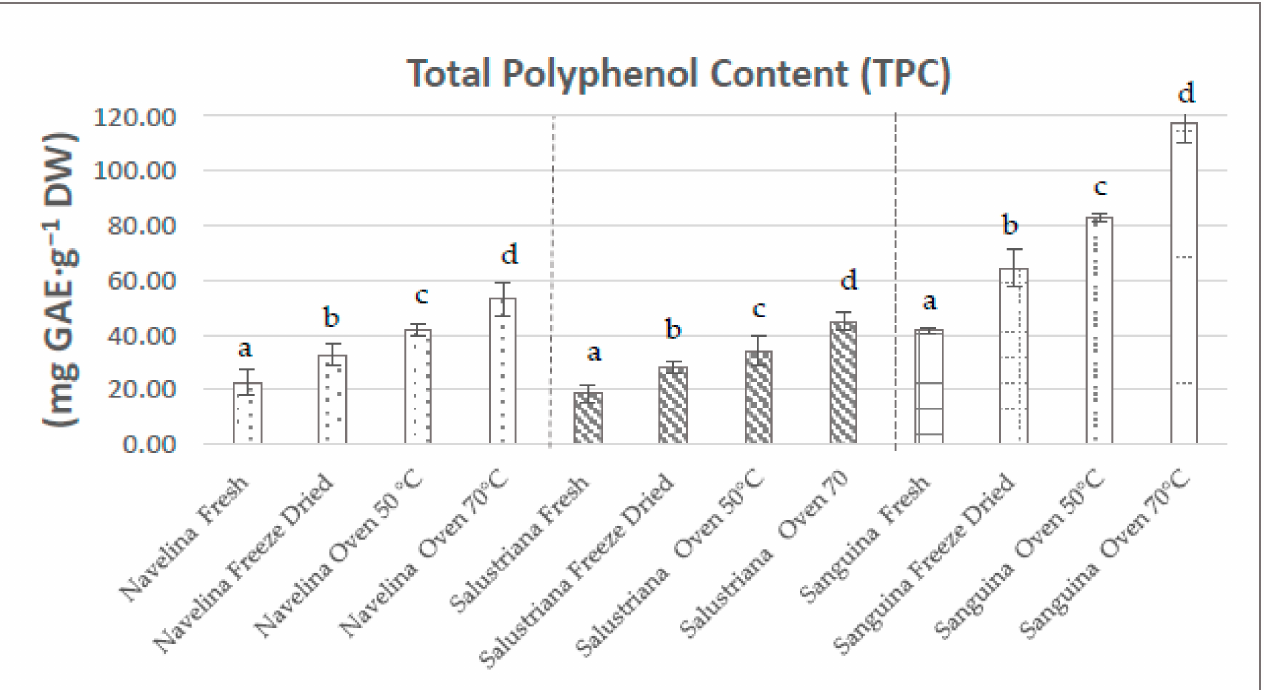
Figure 2. Total phenolic contents of ASE extracts from Navelina, Salustriana, and Sanguina peels, fresh and after different drying treatments. a, b, c, d: Different letters in the same column denote a significant difference according to the Student- Newman-Keuls test, at p < 0.05. GAE—gallic acid